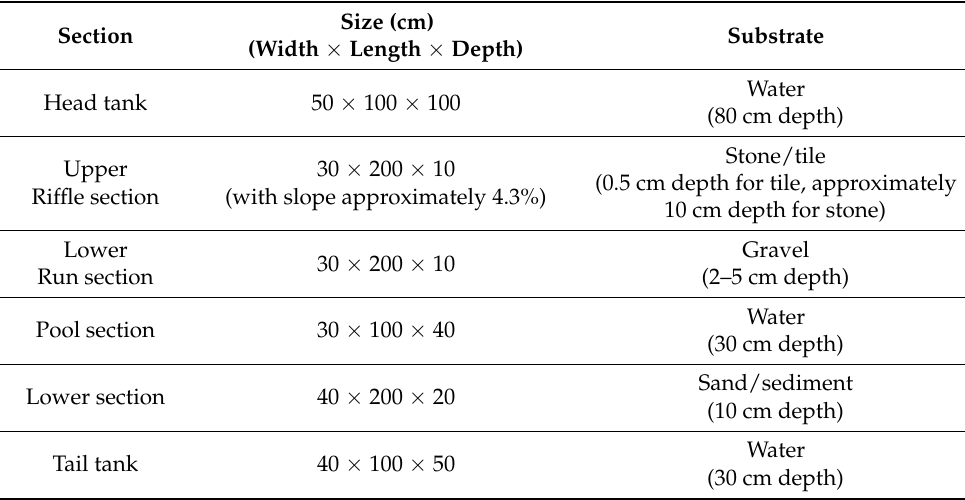
Table 1. Details of each section of the artificial stream mesocosm